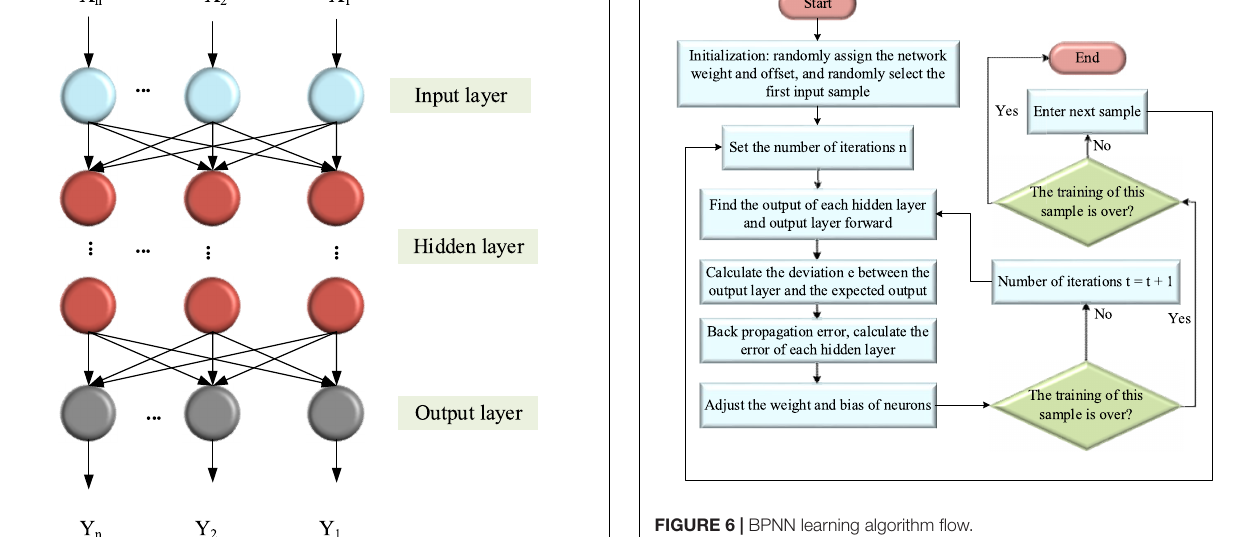
FIGURE 6 | BPNN learning algorithm